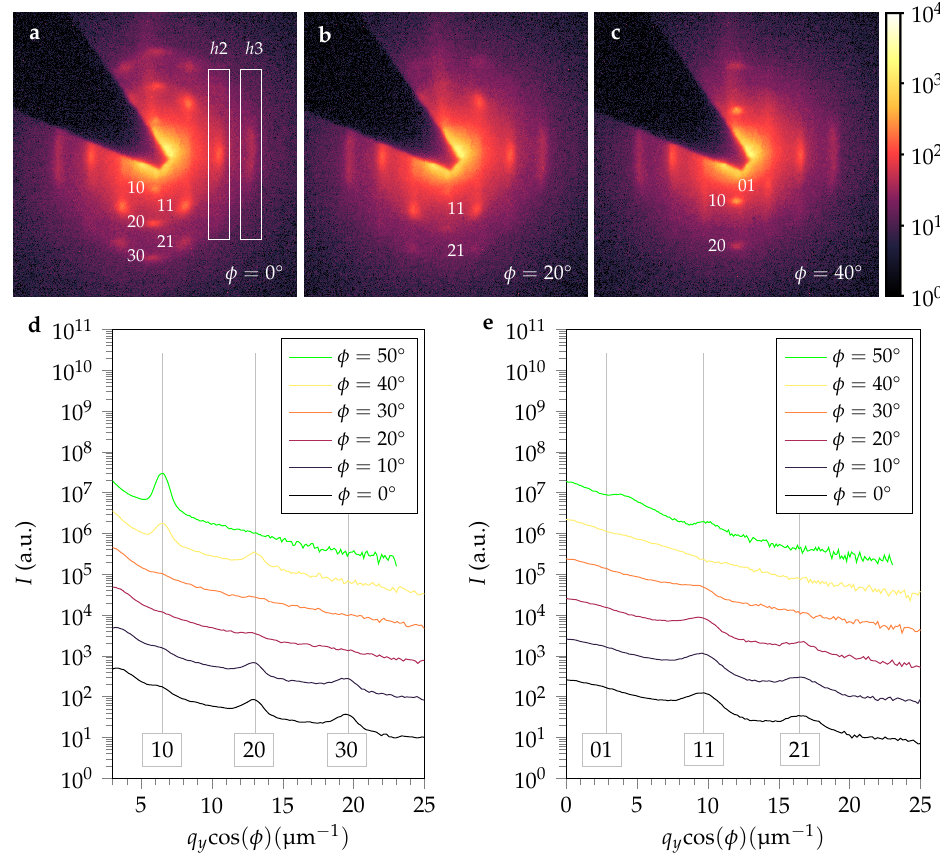
Figure 4. ( a – c ) 2D SAXS patterns of a monolayer prepared from hollow colloidal silica superballs with an average shape parameter of m = 2.87 ± 13% and diameter of D = 0.96µm ± 4.5% imaged at different rotations around the x -axis of φ . The Bragg peaks are labelled on their left. ( d – e ) Vertical cross sections of the diffraction patterns at ( d ) q x = 0µm − 1 and ( e ) q x = 6.12µm − 1 . The vertical lines indicate the q y cos ( φ ) positions of the identified